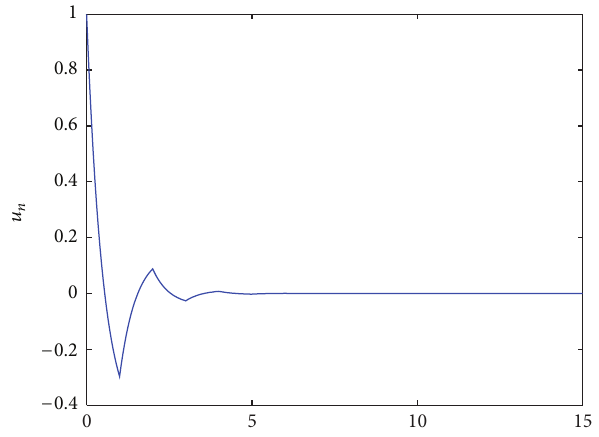
Figure 3: The numerical solution of (38) with 𝑛 = 3 and 𝑚 = 20 .